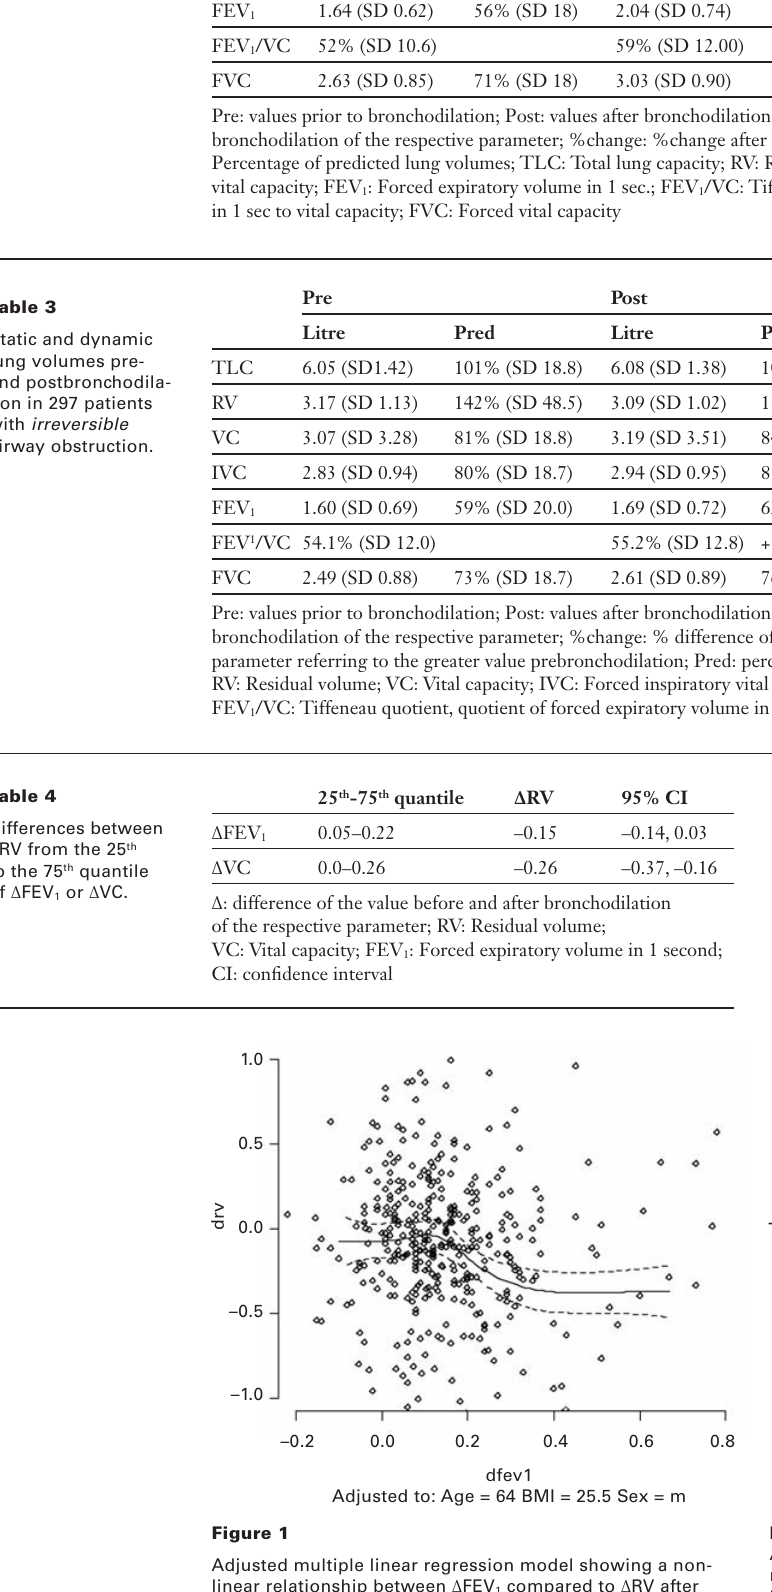
Static and dynamic lung volumes pre- and postbronchodila- tion in 99 patients with reversible air- way obstruction.